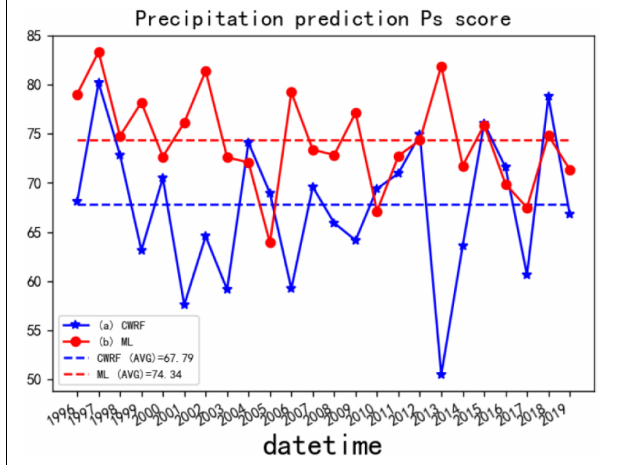
FIGURE 13 | Comparison of Ps before and after CWRF forecast correction for 7 case sets. (a) CWRF forecast, (b) machine learning correction, and (a, b) mean Ps from 1996 to